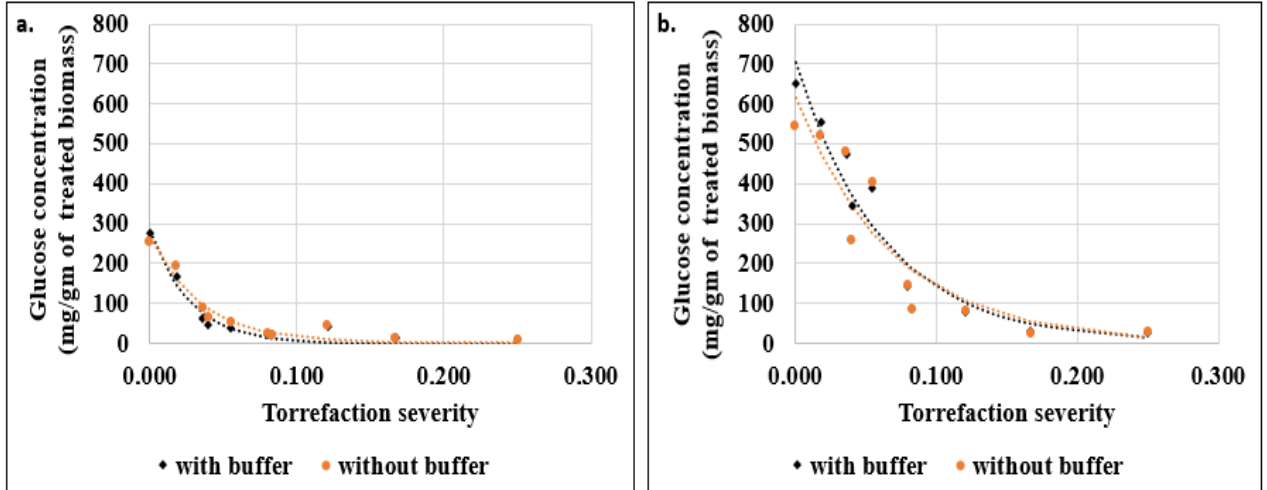
Figure 4. Effect of addition of buffer on glucose yield from samples torrefied at various levels, ( a ) without alkaline pretreatment and ( b ) with alkaline pretreatment before torrefaction. The p -values from paired t-tests were, respectively, 0.32 and 0.16 for samples torre- fied at various levels without alkaline pretreatment versus with alkaline pretreatment be- fore torrefaction. The p -values greater than 0.05 suggest that buffered pH and non-buff- torrefied samples.